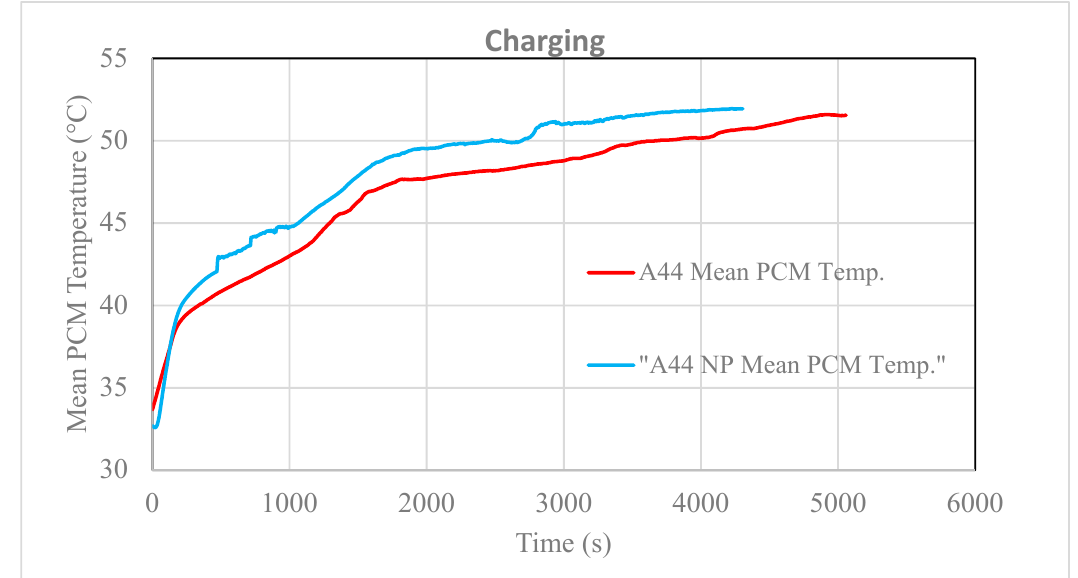
Figure 11. Comparison of HTF temperature evolution in case of pure A44 and A44 with nano-particles (A44 + NP) upon discharging.